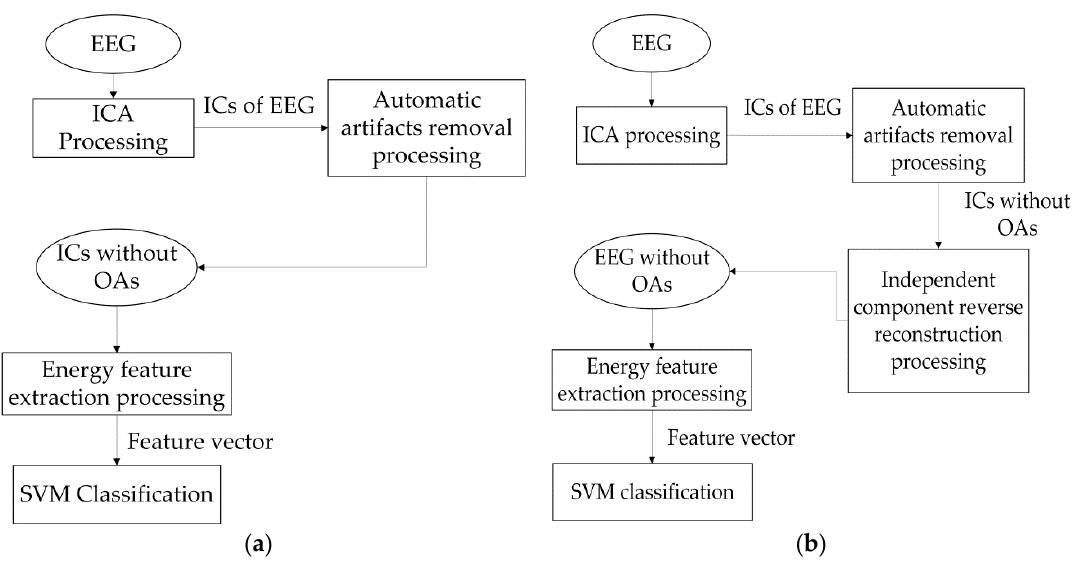
Figure 7. Implementation of Method 3 ( a ) and Method 4 ( b ).